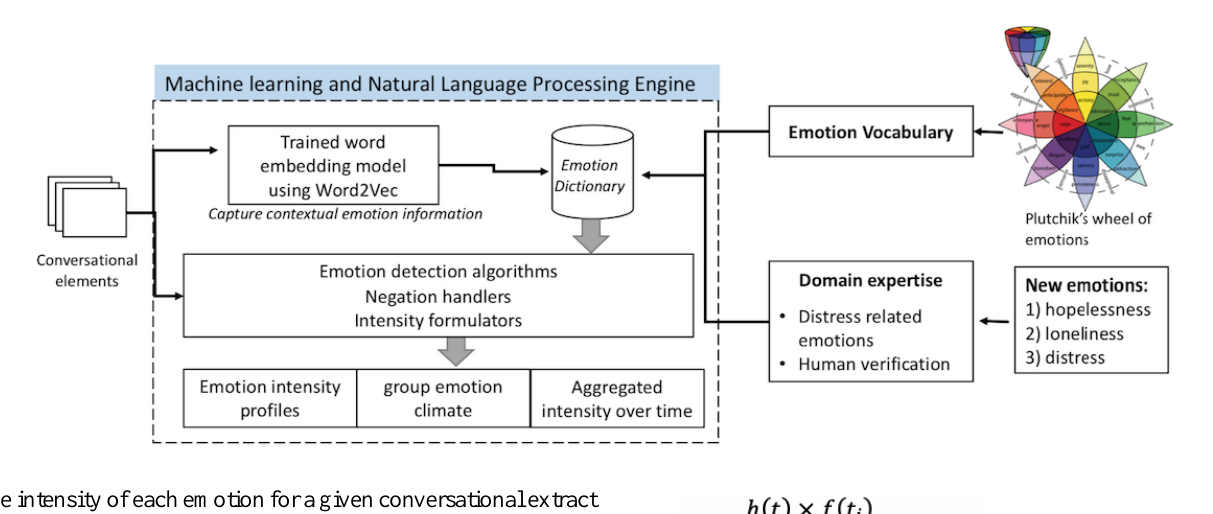
Figure 3. From PRIME to AICF prototype—3-stage transformation